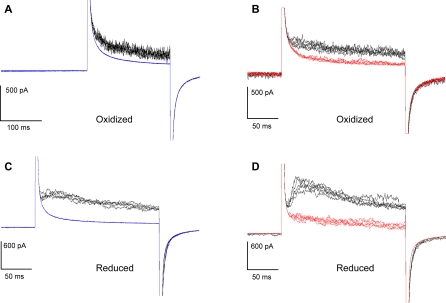
Representative Experiments Showing the Functional Effects of Disulfide Cross-Linking of S1–Pore Interface in KvAPCurrent traces were elicited after depolarization to positive voltages before (black) or after (blue) the addition of BaCl2 to the internal side, or before (black) and after (red) addition of CTX to the external side.(A and B) Air-oxidized 47Cys/183Cys KvAP.(C and D) DTT reduced 47Cys/183Cys (See Materials and Methods). Every experiment is from a separately painted membrane.